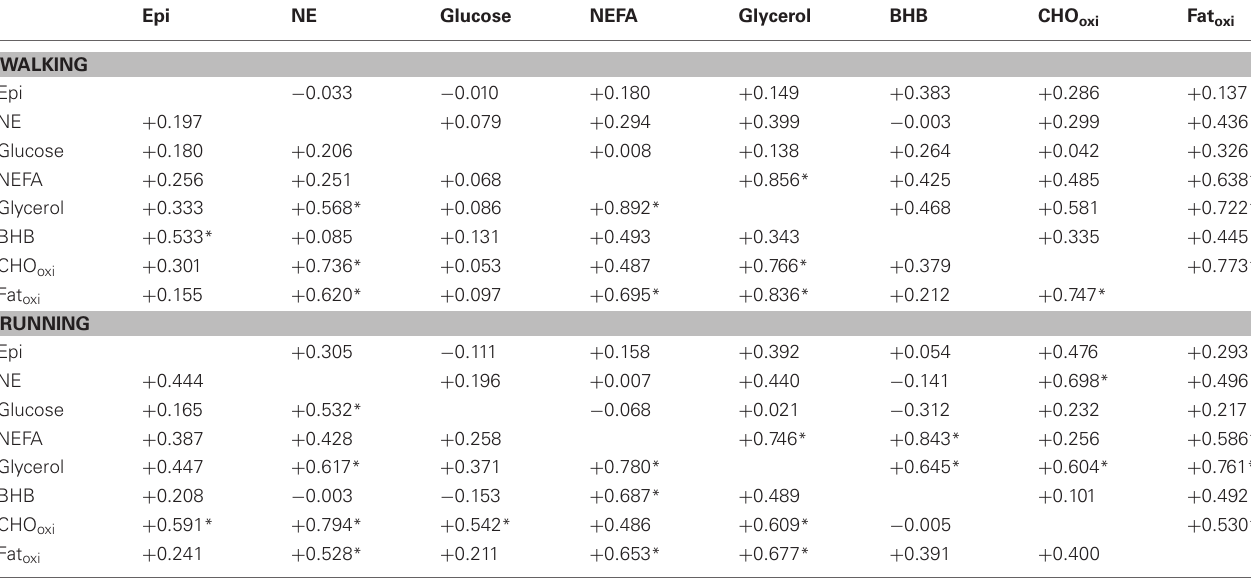
Table 3 | Correlations coeffients between plasma catecholamines, serum concentrations and substrates oxidation during walking and running in both cold and neutral environmental conditions. Epi NE Glucose NEFA Glycerol BHB CHO oxi Fat